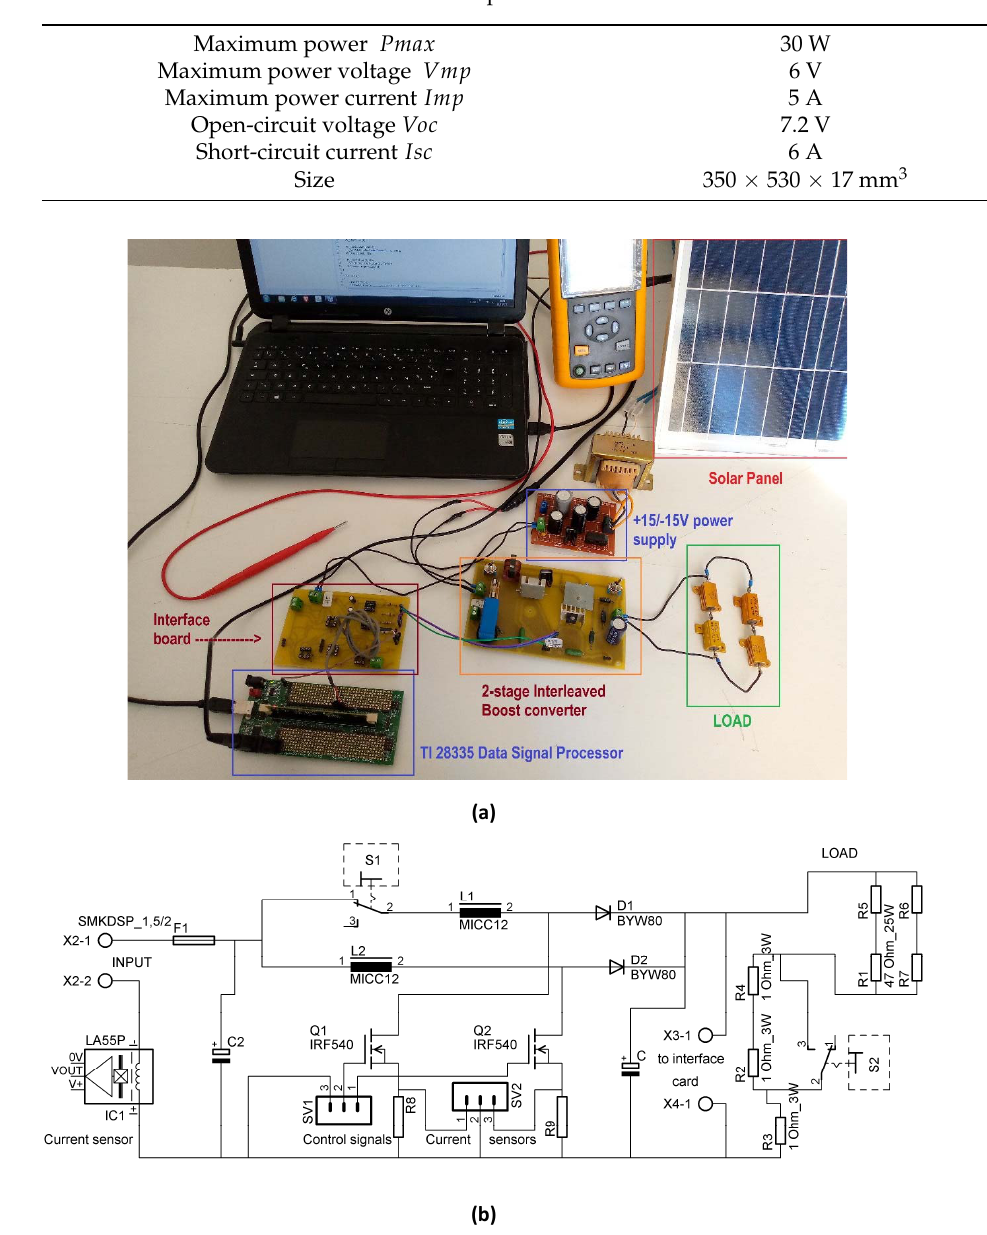
Figure 12. The experimental prototype: ( a ) a photo of the prototype; and ( b ) the electronic schematic of the power